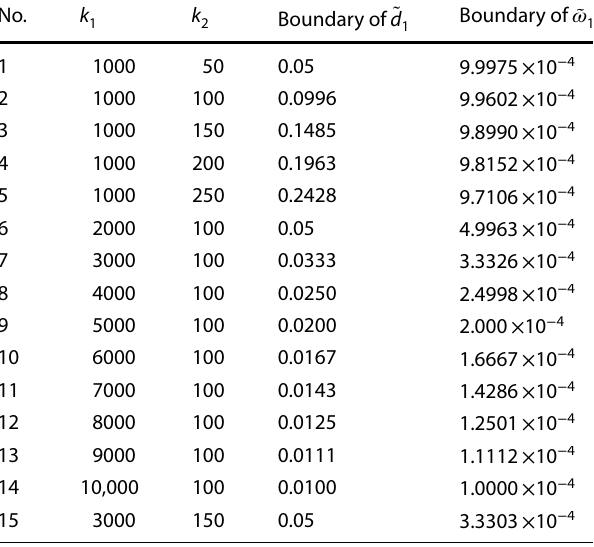
Table 1 Observer errors with parameters k 1, k 2 changing